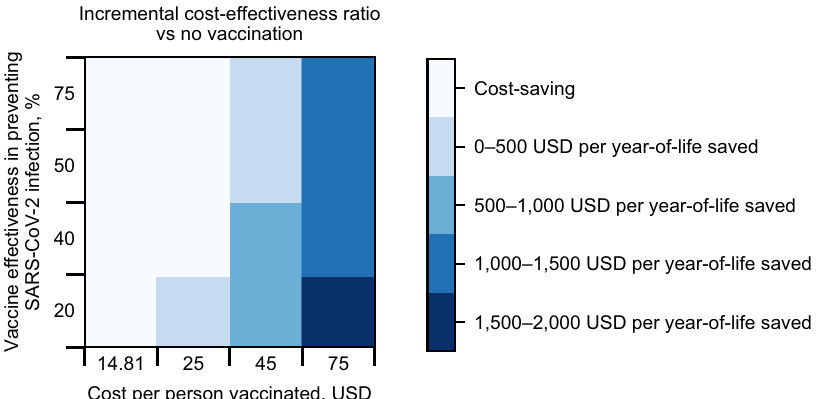
Fig. 2 Multi-way sensitivity analysis of vaccine effectiveness against infection and vaccination cost: incremental cost-effectiveness ratio of vaccination program compared with no vaccination. Each box in the 4 × 4 plot is colored according to the incremental cost-effectiveness ratio (ICER). The lightest color represents scenarios in which a reference vaccination program (vaccine supply suf fi cient for 67% of South Africa ’ s population, pace 150,000 vaccinations per day) is cost-saving compared with no vaccination program, meaning that it results in clinical bene fi t and reduces overall health care costs. The darker colors re fl ect increasing ICERs, whereby a reference vaccination program, compared with no vaccination program, results in both clinical bene fi t and higher overall health care costs. The ICER is the model-generated difference in costs divided by the difference in years-of-life between a reference vaccination program and no vaccination program. In none of these scenarios is the ICER above $2000/year-of-life saved